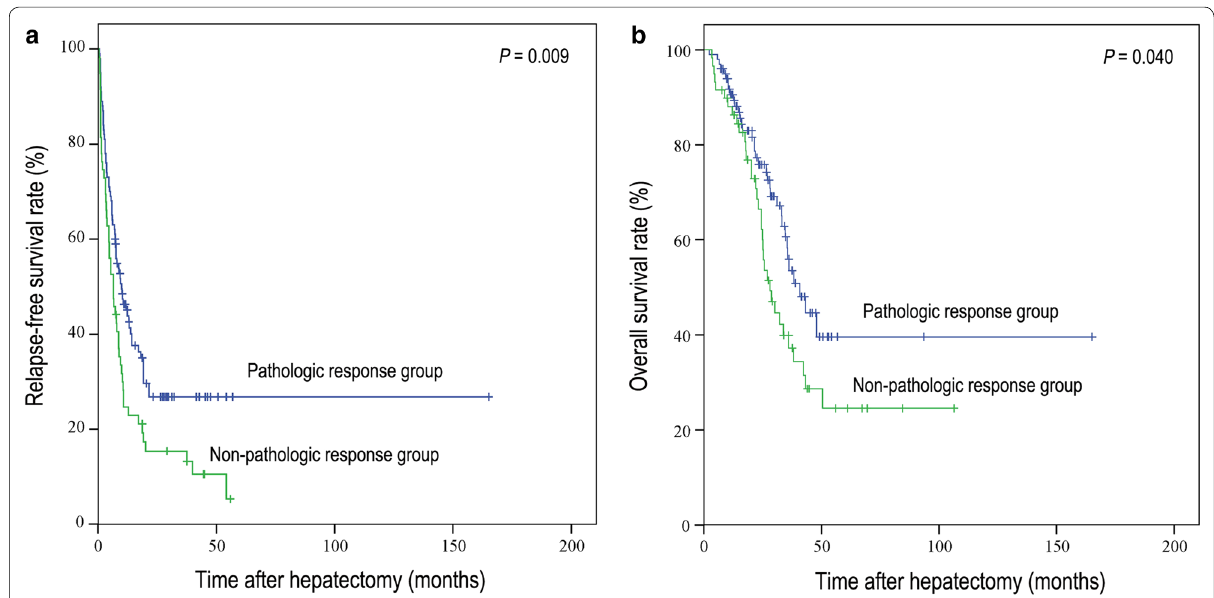
Fig. 2 Kaplan–Meier curves of relapse‑free survival ( a ) and overall survival ( b ) in colorectal cancer patients with liver metastases after hepatec‑ tomy based on pathologic response. Patients in the pathologic response group had a longer recurrence‑free survival (RFS) (median RFS: 9.9 vs.